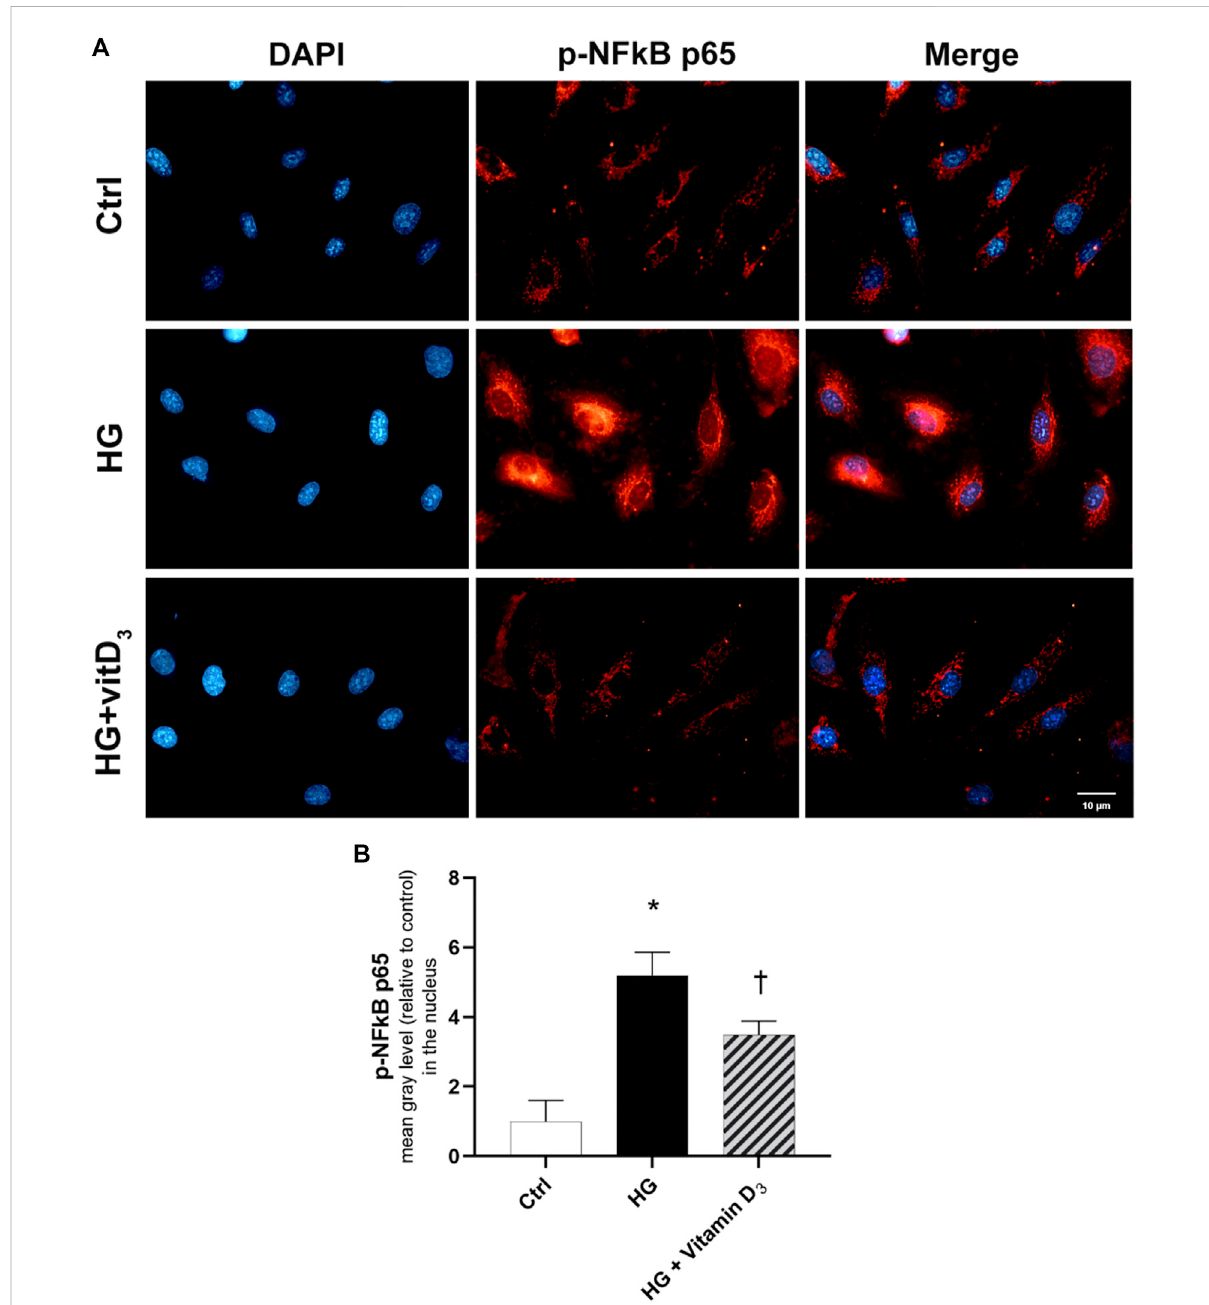
FIGURE 6 EffectofvitaminD 3 onNF- κ BactivationinHG-challengedHRECs. (A) Representativeimagesofphosphorylatedp-NF κ Bp65(red)translocation into the nuclei (blue) stained with DAPI. HRECs were pre-treated with vitamin D 3 (1 µM) for 24 h and then with or without high glucose for 24 h. (B) Fluorescence semi-quanti fi cation of p-NF κ B p65 protein (mean grey levels) into the nucleus. Nuclei were labeled with DAPI (blue). Images were acquired at × 40 magni fi cation. Scale bar: 10 µm. Values are reported as mean ± SD; n = 4. Data were analyzed by one-way ANOVA and Tukey post-hoc test for multiple comparisons. * p < 0.05 vs. control; † p < 0.05 vs.